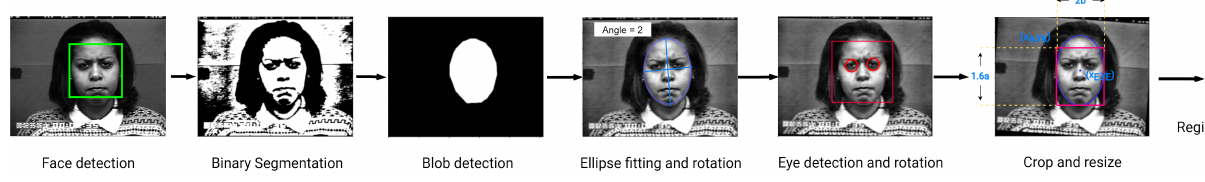
Figure 3. Face detection and